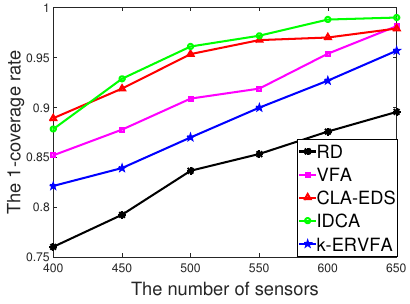
Figure 5. Comparison of the coverage rate among five sensor deployment algorithms. ( a ) Comparison of the three-coverage rate among five sensor deployment algorithms; ( b ) Comparison of the two-coverage rate among five sensor deployment algorithms; ( c ) Comparison of the one-coverage rate among five sensor deployment